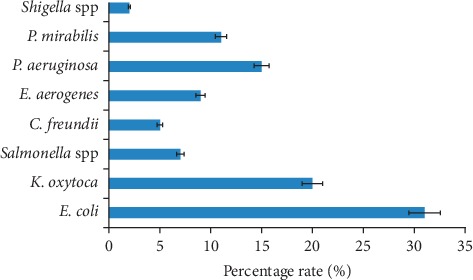
Distribution of enteric bacteria obtained from the subjects.